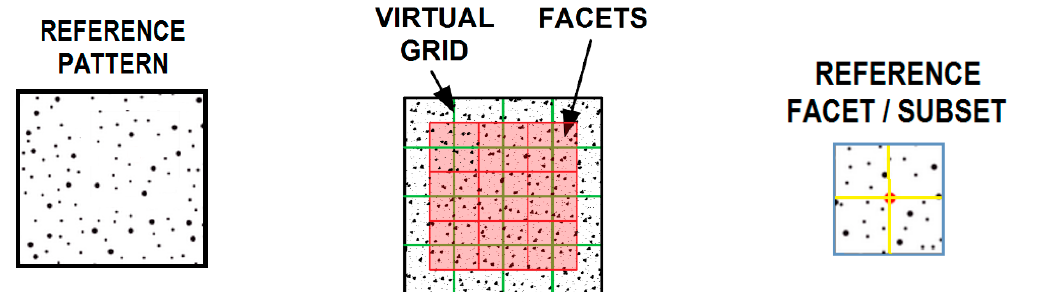
Figure 2. DIC method—Reference image: facets (also called subsets) marked with blue squares and centre points of the facets/subsets located at the intersection of the yellow virtual grid [17,18].